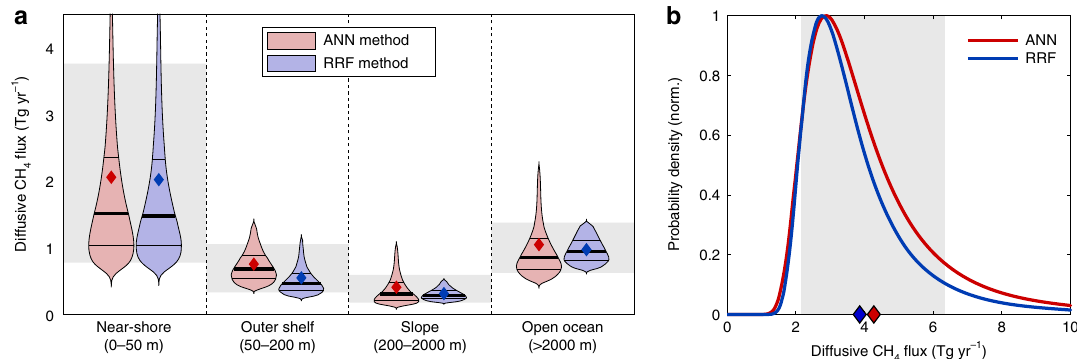
Fig. 4 Regional and global diffusive CH 4 emissions. a Violin plot for annual diffusive CH 4 emissions integrated across four bathymetric regions, computed using Monte Carlo method to propagate uncertainty in Δ CH 4 and gas transfer velocity. Violin thickness corresponds to probability density, with think black lines at 25th and 75th percentiles, thick line at median, and diamond at mean value. Light gray shading for each region spans the 10 – 90th percentiles for all estimates, combining arti fi cial network (ANN) and random regression forest (RRF) ensembles. b Probability density functions for globally integrated CH 4 emissions from ANN and RRF methods. Diamonds and light gray shading as de fi ned in